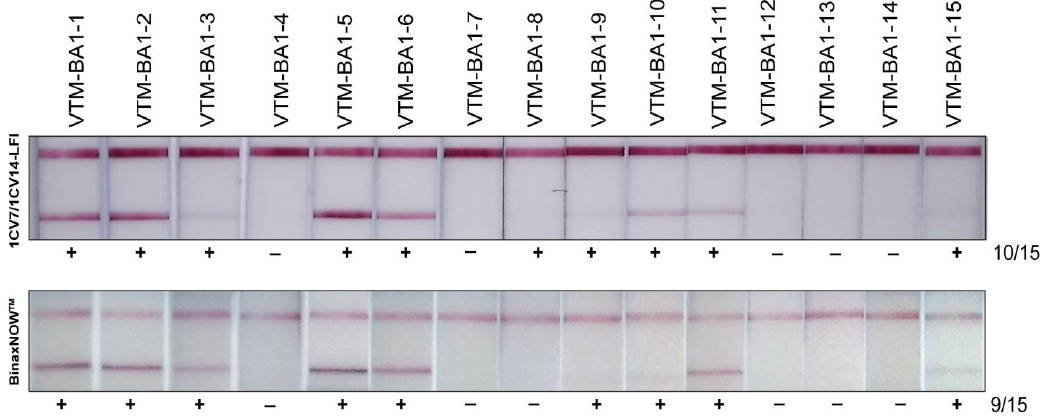
Figure 3. Sensitivities of the 1CV7/1CV14 LFI and BinaxNOW TM in detecting Omicron (BA.1) variant in clinical samples.